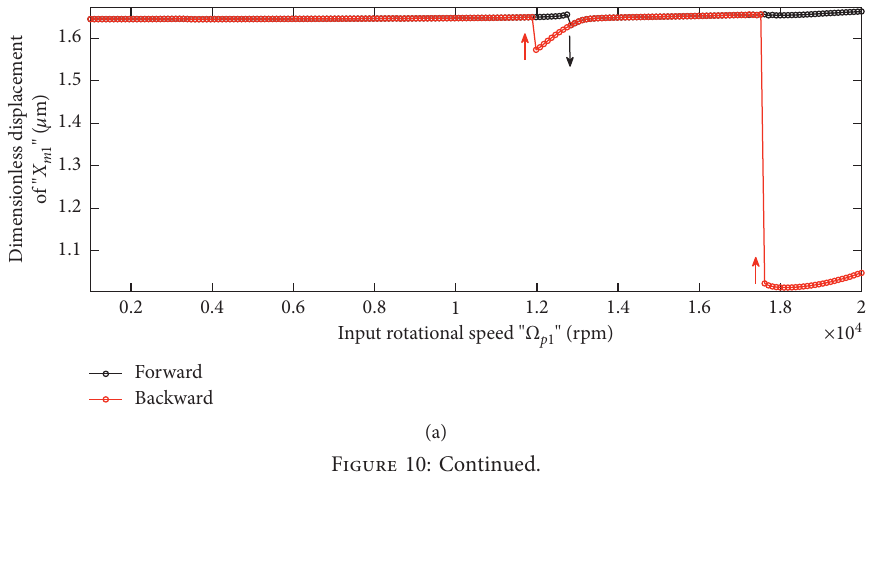
� s � 40 μ m. (a) X 1 2